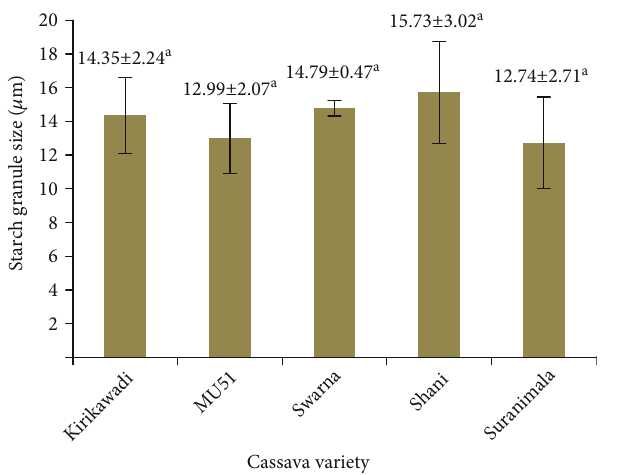
Figure 6: Starch granule size of cassava fl ours from fi ve Sri Lankan cassava varieties. Values are expressed as mean ± standard deviation of three independent determinations. Di ff erent superscripts represent signi fi cantly di ff erent samples ( p < 0 : 05 ).